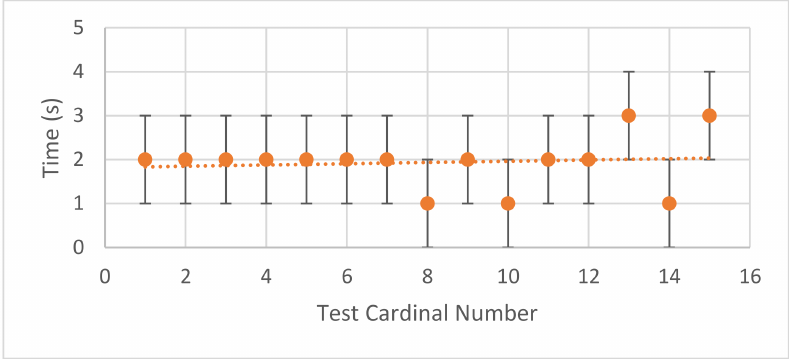
Figure 13. The time between the removal of a battery cell and its reporting in the HMI application for 15